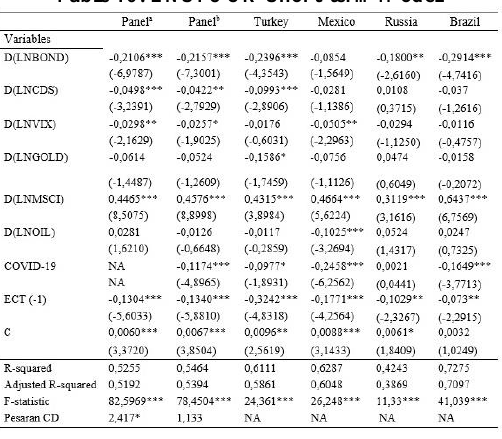
Table 10: LNSTOCK Short-term